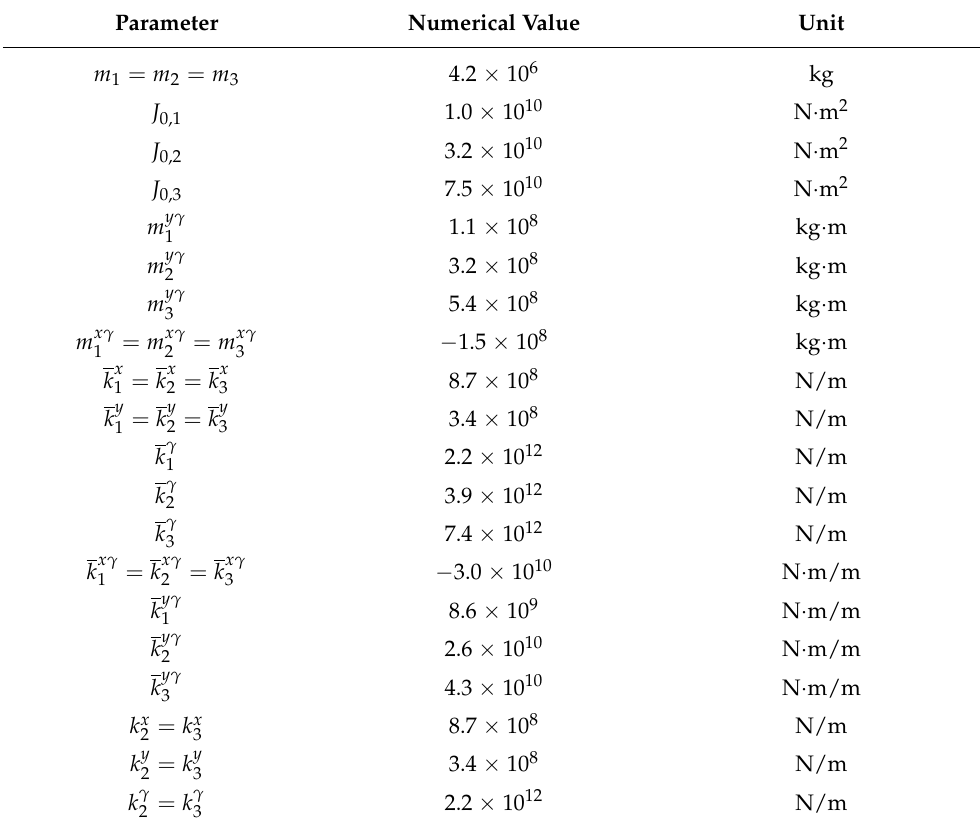
Table 1. Numerical values of